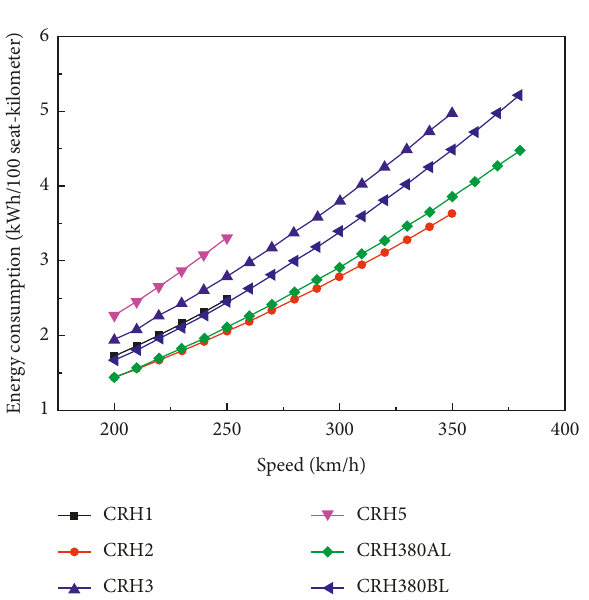
Figure 2: Energy consumption (kWh) per 100 seat-kilometer of different EMU models on a flat and straight line based on the resistance